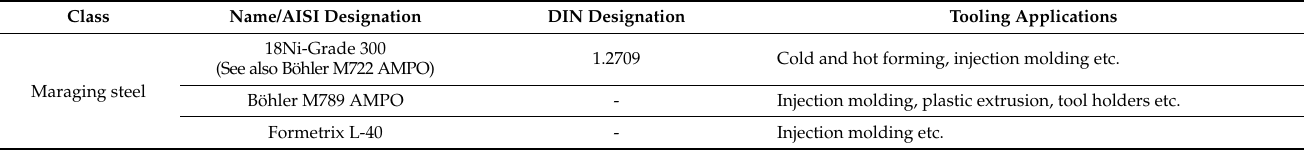
Table 5. L-PBF: the major tool powder steels so far and the associated tooling